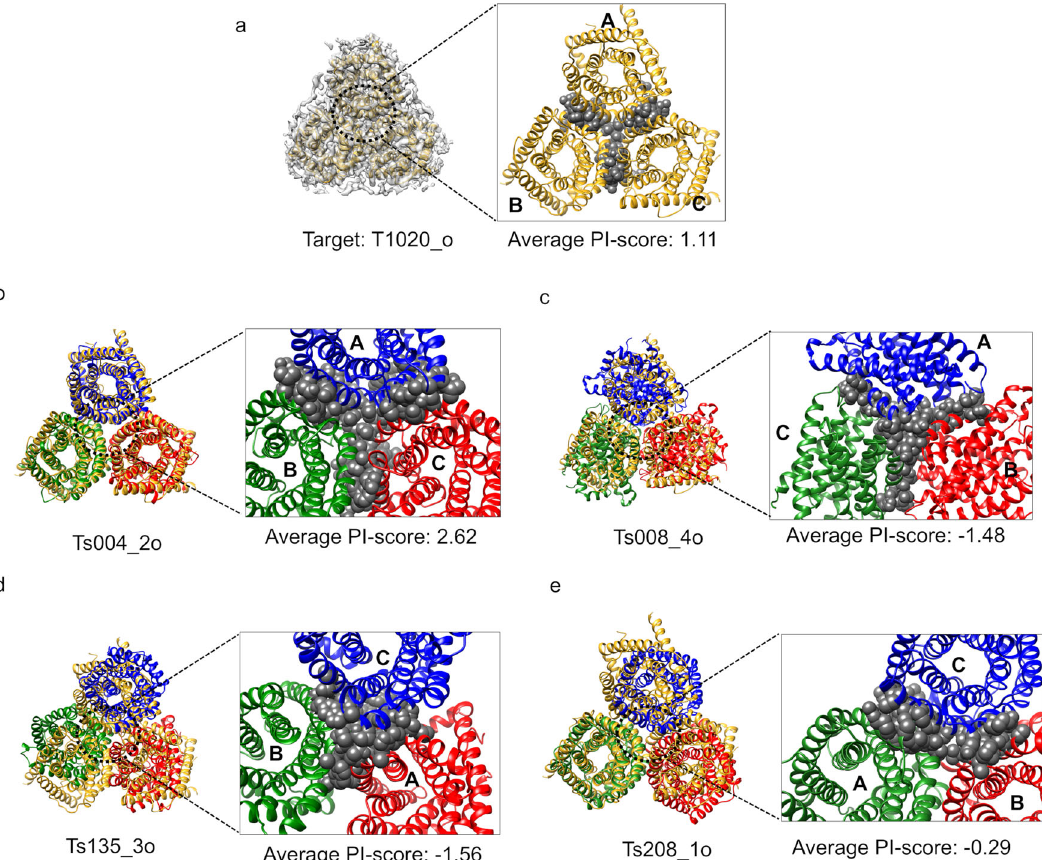
Fig. 3 Scoring the interfaces in the oligomeric CASP13 target T1020o. The target structure is shown in gold in all the panels and the model structures being assessed are shown in red, green and blue. The chains are labelled accordingly. a Target structure within the cryo-EM map. The interface residues from the three chains are shown as grey spheres. b Model TS004_2o, with a positive PI-score for all the three interfaces in the trimeric assembly.